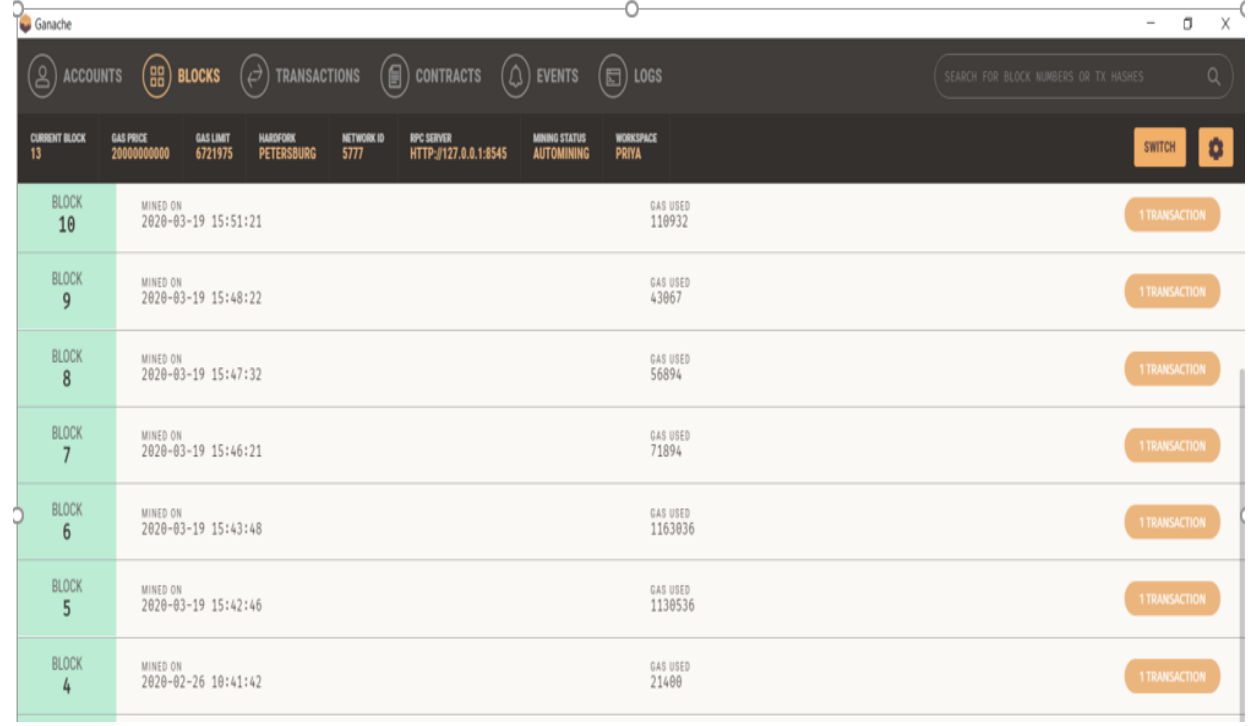
Figure 5. Blocks information in Ganache. Table 5. Comparison with existing related